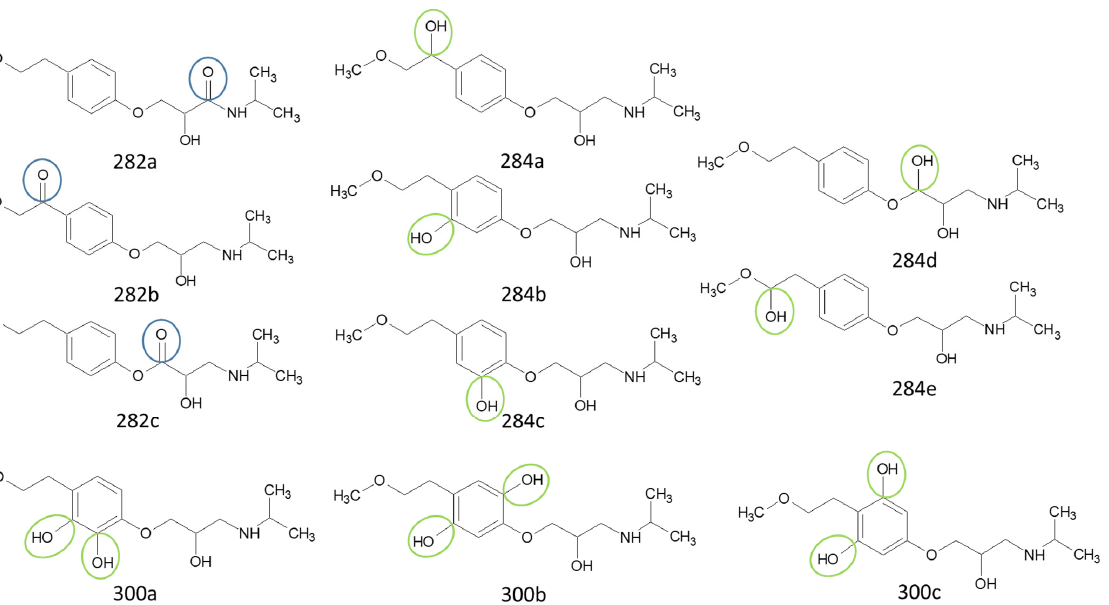
Table 4. QSAR analysis of metoprolol and with less (green) and more hazardous (red) degradation and transformation products from UV irradiation and ozonation using the OECD-QSAR toolbox. Daphnid ( Branchi-